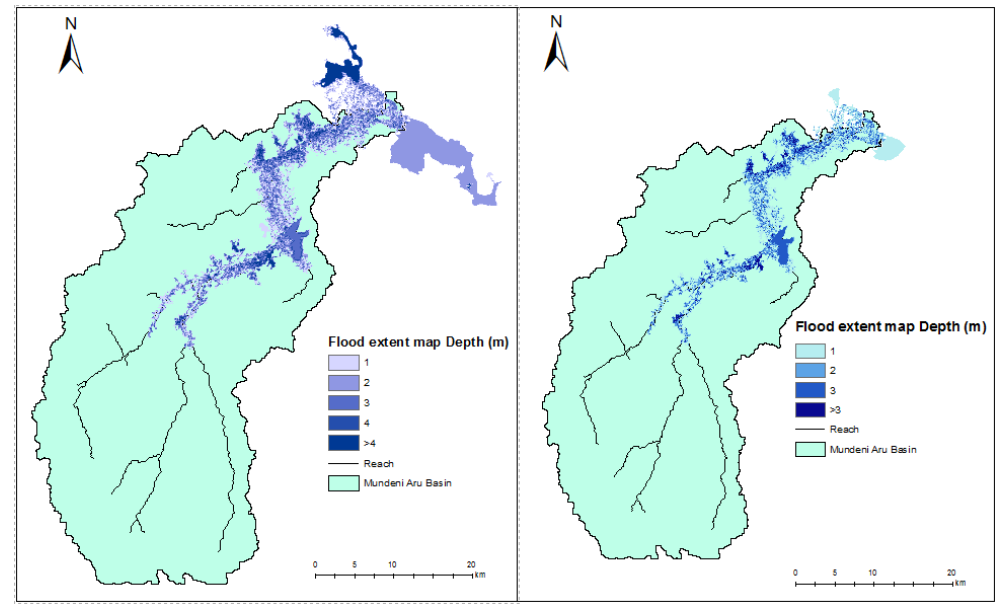
Figure 5. Flood extent map in the Mundeni Aru River Basin: without countermeasures (left) with countermeasures (right).